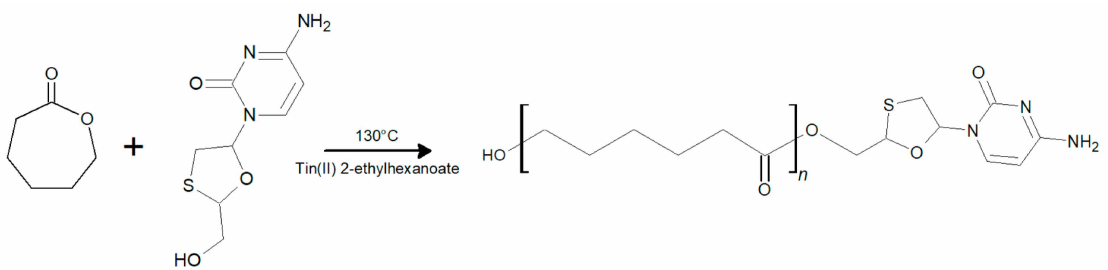
Scheme 1. Ring-opening polymerization of ε -caprolactone initiated by lamivudine.